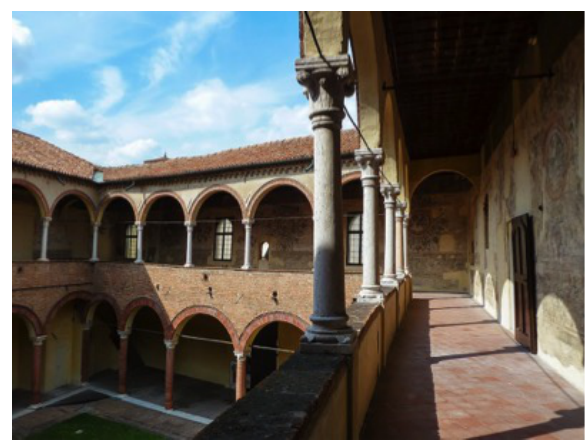
Figure 1. Inner yard of Casa Romei.